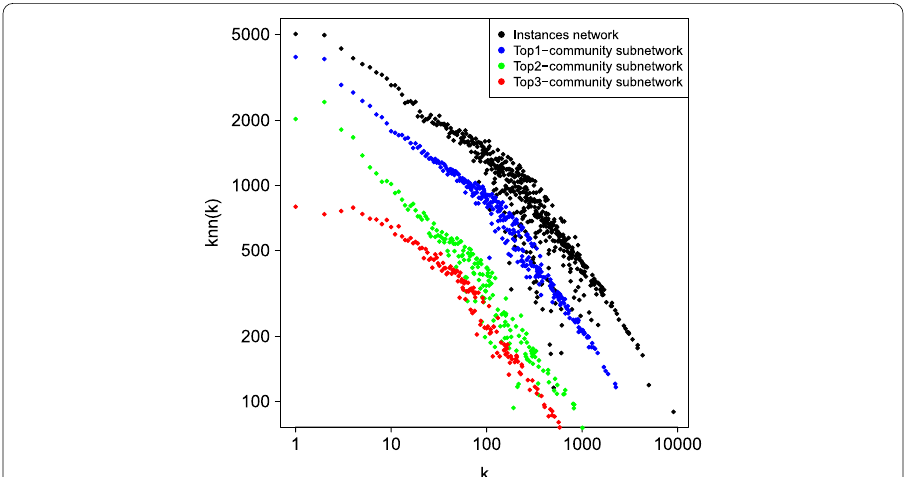
Fig. 6 Illustration of the average nearest neighbor degree knn ( k ) as a function of the degree k . Values on the x-axis and y-axis are log scaled. The three largest community subnetworks are extracted from the structure obtained by the weighted directed Louvain method on the I nstancEs